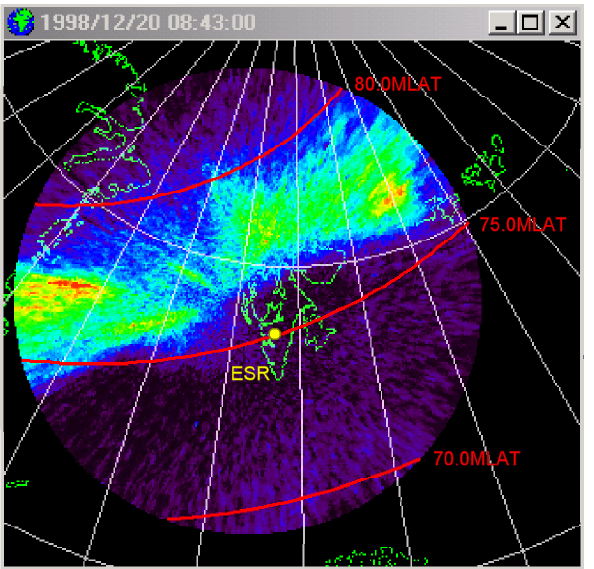
Fig. 3. Intensity of 630.0nm (red-line) emission measured by the all-sky camera at Longyearbyen at 08:43 UT, 20 December 1998, representative of the time period of interest. The white traces show the geographic grid, while geomagnetic latitudes are shown by the superimposed red curves. The intersection of the ESR radar beam with an altitude of 220km is indicated by the yellow dot near 75 ◦ MLAT.